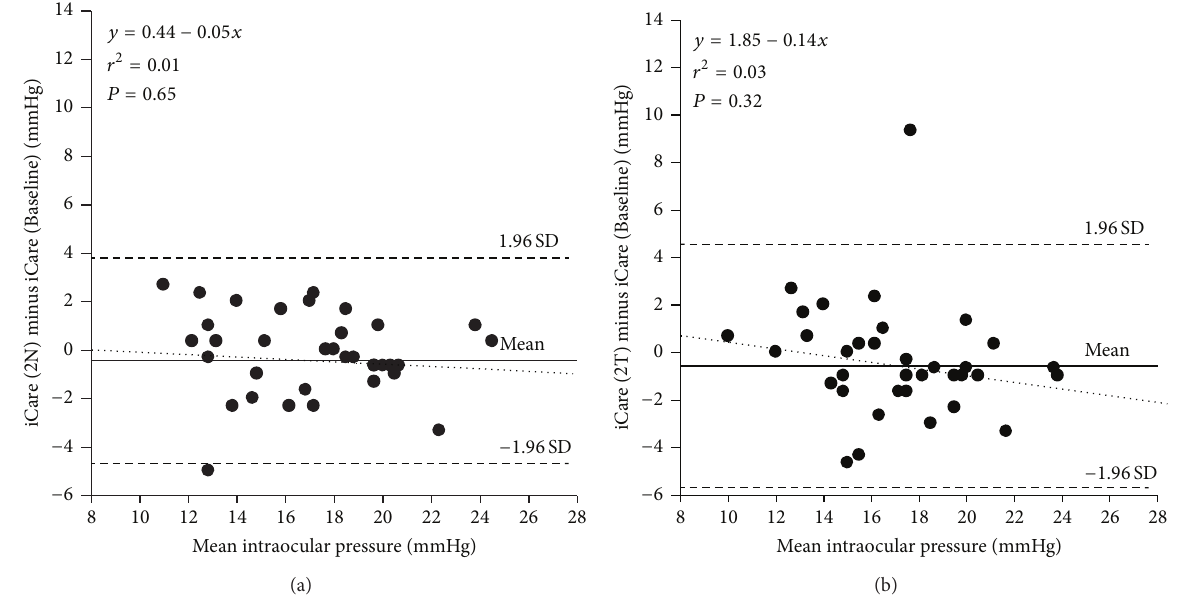
Figure 4: Difference versus mean plot illustrating the comparison between IOP measurements taken with the iCare tonometer at the baseline position (CC) and at specified lateral deviations. (a) iCare tonometer probe was laterally displaced 2mm nasally from the centre of the cornea. (b) iCare tonometer probe was laterally displaced 2mm temporally from the centre of the cornea. The solid line represents the mean bias, and the dashed lines represent the 95% limits of agreement with the dotted regression line displayed. Lateral deviation of the probe showed no significant correlation with measures at CC in nasal or temporal